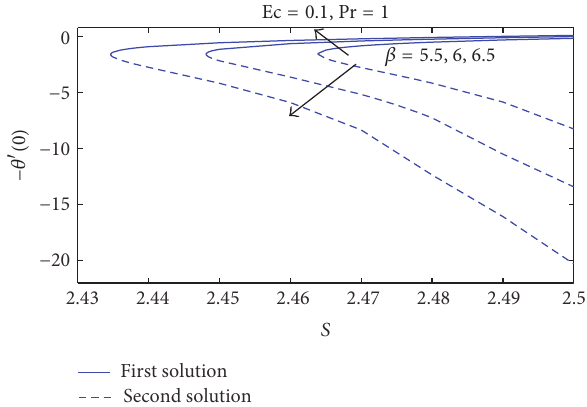
Figure 3: Heat transfer coefficient −𝜃 󸀠 (0) with 𝑆 for different values of 𝛽 .